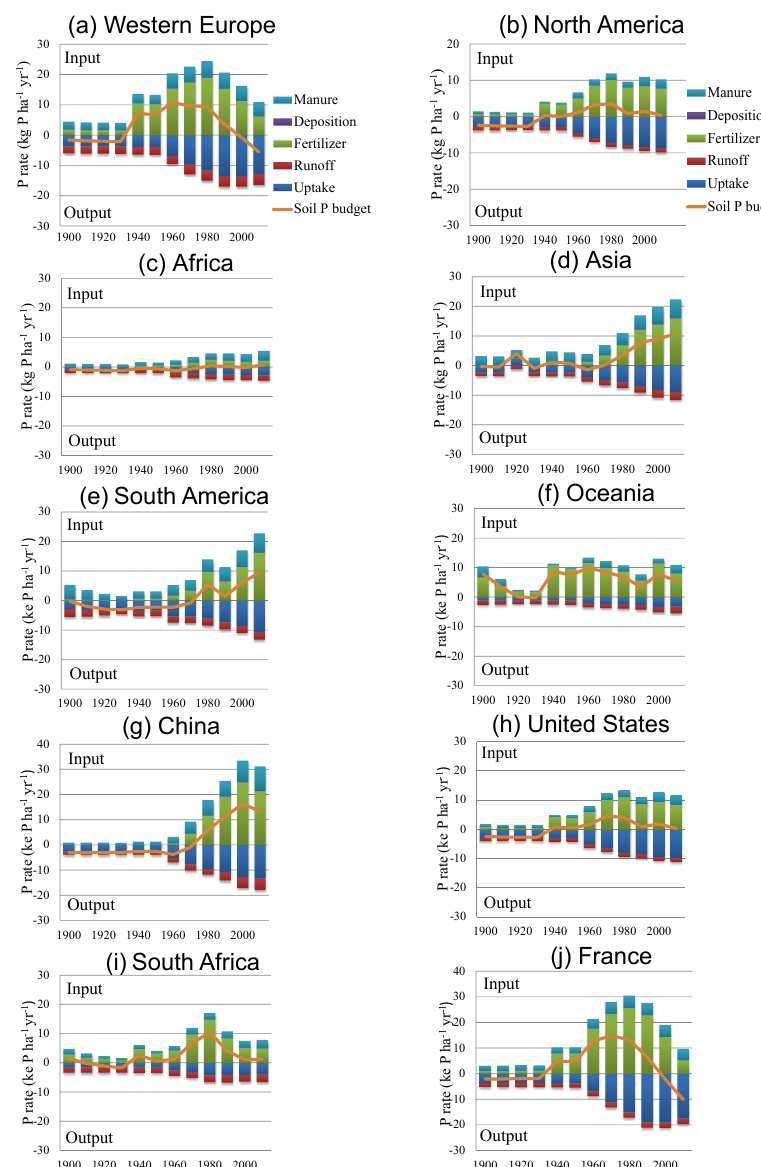
Figure 5. The total soil P inputs (fertilizer, manure, and deposition), soil P outputs (crop uptake and runoff), and biogeochemical soil P budget (soil P input − soil P output) of different regions and countries. Soil P inputs are positive and outputs are